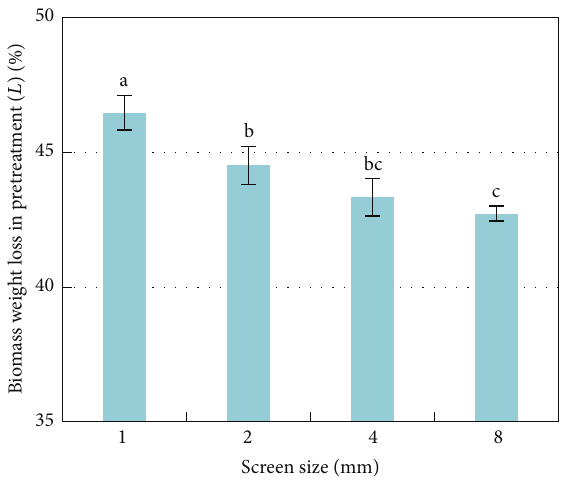
Figure 11: Effects of screen size on enzymatic hydrolysis